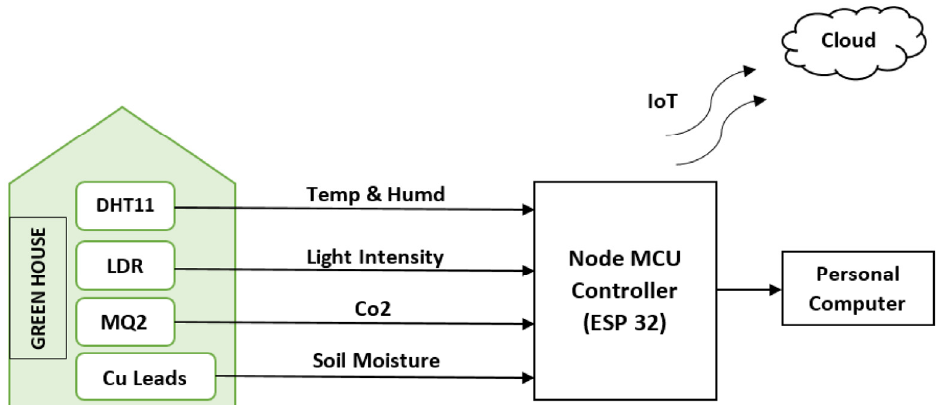
Figure 3 . Proposed experimental model. Figure 3. Proposed experimental model.